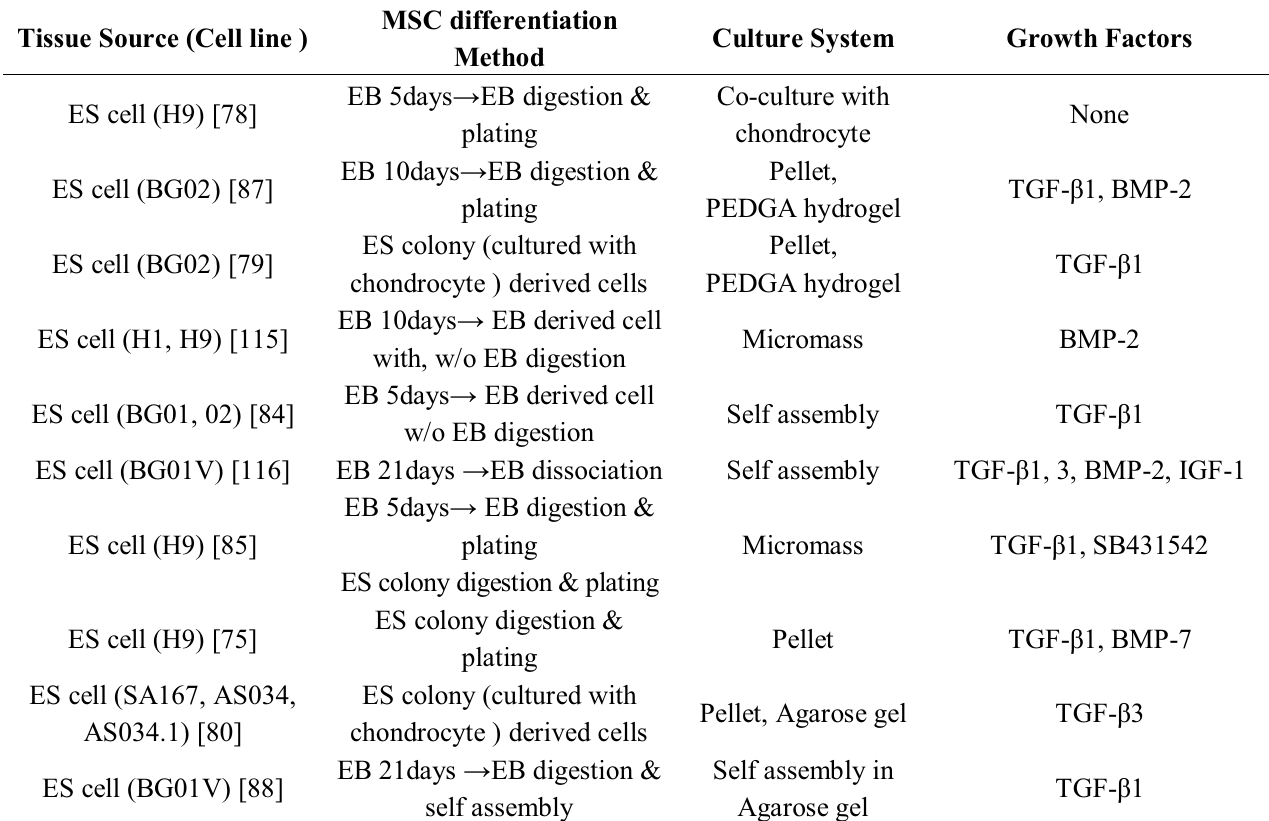
Table 2. In vitro chondrogenesis using human ES and